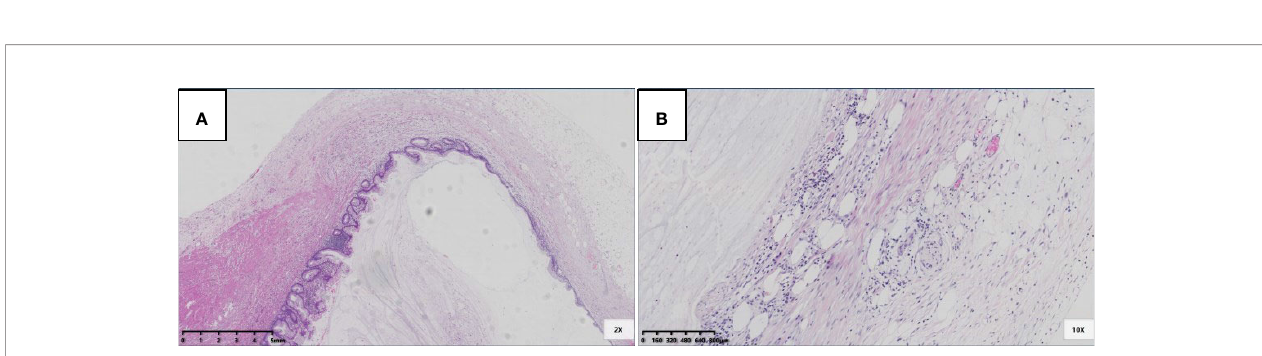
FIGURE 4 | Pathological morphology of pT4a. (A) Flat and clustered low-grade mucinous epithelium lined in the inner side of the fi brotic mucosa (black arrow), and acellular mucinous with in fl ammatory reaction was found (HE 40×); (B) The structure of serosa was destroyed and replaced by acellular mucinous with in fl ammatory reaction (HE 100×).